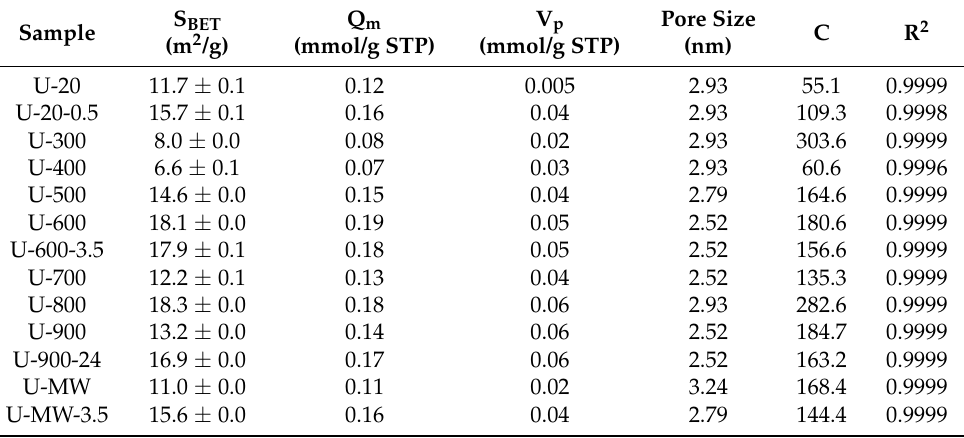
Table 5. Specific surface area (S BET ), adsorption capacity (Q m ), pore volume (V p ), BET constant C, and correlation coefficient (R 2 ) results from adsorption-desorption nitrogen measurements for raw and treated